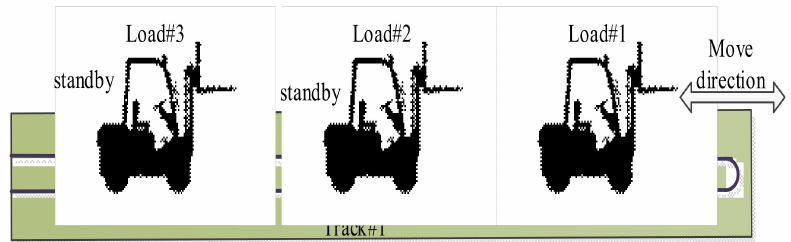
Figure 9. Analytical diagram of the motion state of three loads.